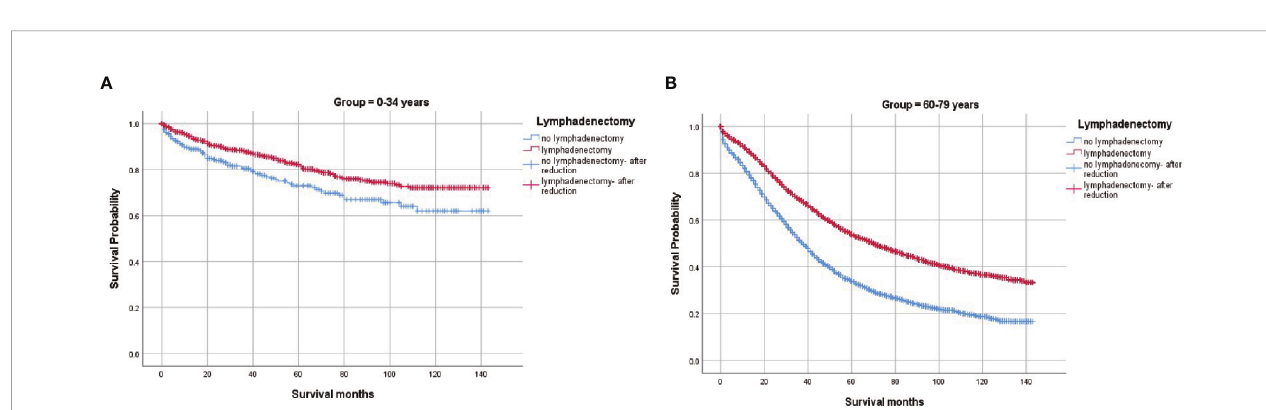
FIGURE 3 | Cause-speci fi c survival by lymphadenectomy in women aged <35 and women aged 60 to 79 diagnosed with epithelial ovarian cancer. (A) Lymphadenectomy in women aged <35; (B) Lymphadenectomy in women aged